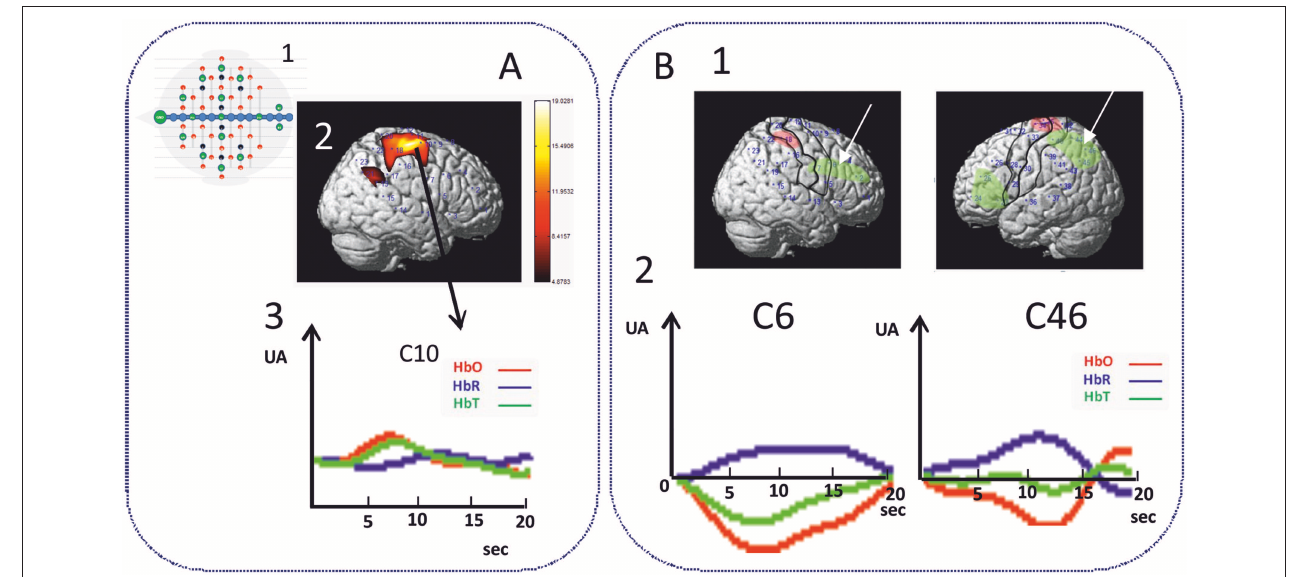
FIGURE 3 | Hemodynamic response of functional disorganization in the epileptogenic zone (A) in remote regions (B) . A1 High density EEG-fNIRS drawing of the bimodal EEG-fNIRS cap with optodes (detectors, green; emitters, red) and electrodes (black) positions. Twenty three channels per hemispheres have been considered corresponding to distances between emitting and detecting fibers (1.5 to 4cm). A2 Hemodynamic responses related to right centro-temporal IES in a patient with typical ECTS. Statistical map of the hemodynamic response using a typical Hemodynamic Response Function ( p < 0.05) and (3) Traces of the hemodynamic response after averaging (0-20 seconds) of the related channel 10 (C10). IES in ECTS are associated with a typical positive hemodynamic response, as demonstrated by EEG-fNIRS in the centro-temporal area [ adapted from Bourel-Ponchel et al. [ 130 ]]. B1 Positive and negative neurovascular coupling areas (in red and green, respectively) calculated from a typical Hemodynamic Response Function (HRF) ( p < 0.05). B2 Negative neurovascular coupling obtained with averaging method (range considered 0–20s) in right frontal and left parieto-occipital areas (arrows). High density optical imaging found increase in HbR and decrease in HbO (corresponding to a negative BOLD) in the same regions (bi-frontal areas and left occipital areas) ( 136). x Axis: time range between 0 and 20s (interval between vertical bars: 5 sec). y Axis: arbitrary unit (UA): relative concentrations variations related to IES. Red curve: HbO, Blue curve: HbR, Green curve: